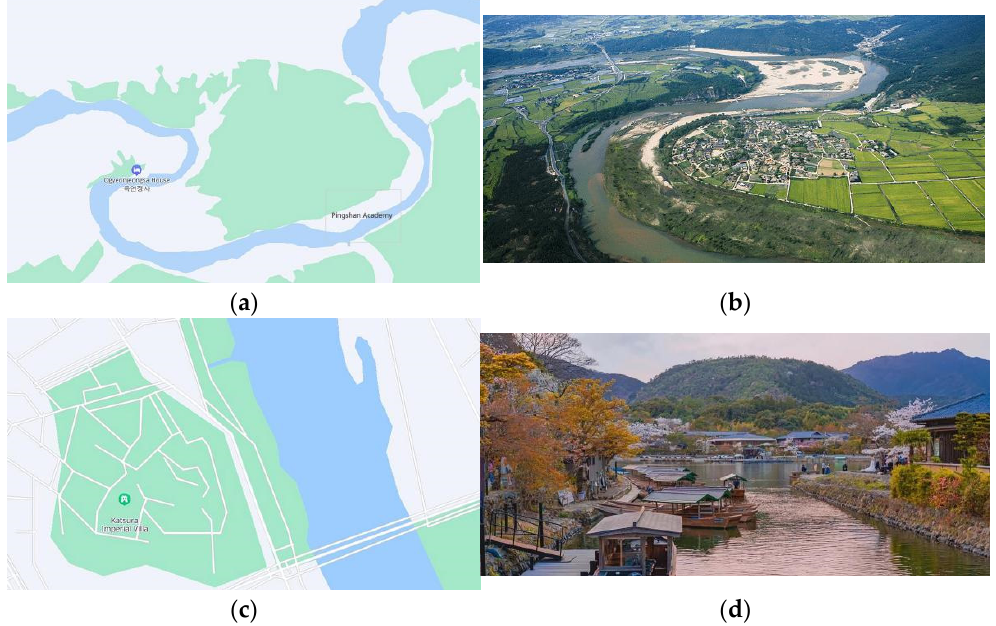
Figure 3. ( a , b ) Location Map of Pingshan Academy (source: Google Maps); ( c , d ) geographical map of Katsura Imperial Villa (source: Google Maps).